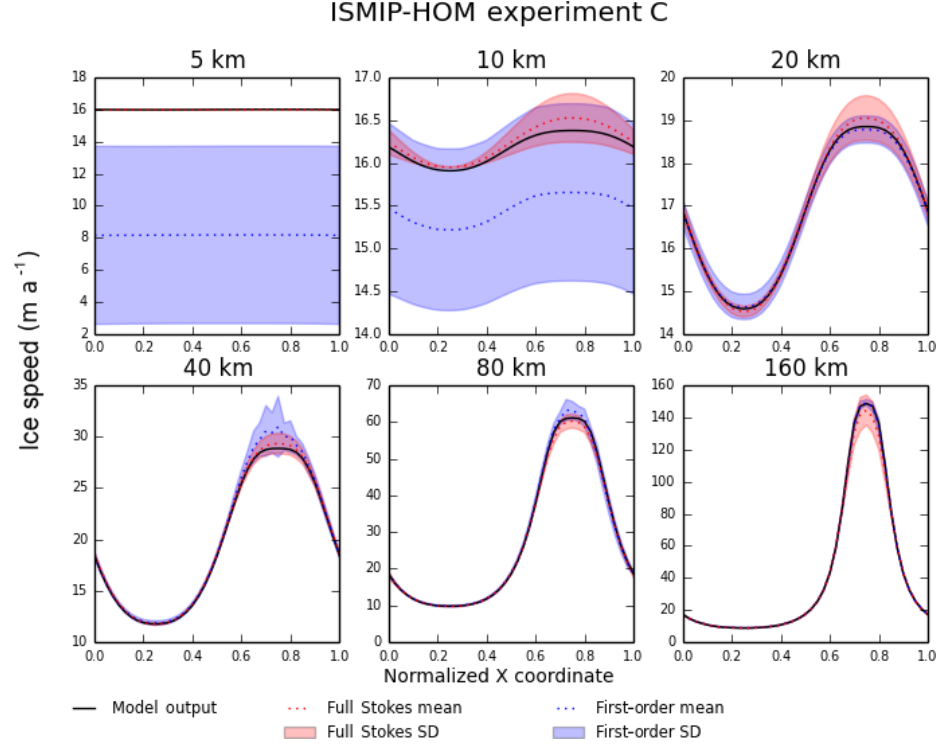
Figure 4. Results for ISMIP-HOM experiment C (ice flow over a bed with variable basal friction). Each plot shows the surface ice speed across the bump at y = L/ 4 for a different length scale L . The solid black line shows output from Glissade’s BP velocity solver; the dotted red and blue lines show output from Stokes and first-order models, respectively, in Pattyn et al. (2008), and the red and blue shaded regions show the corresponding standard